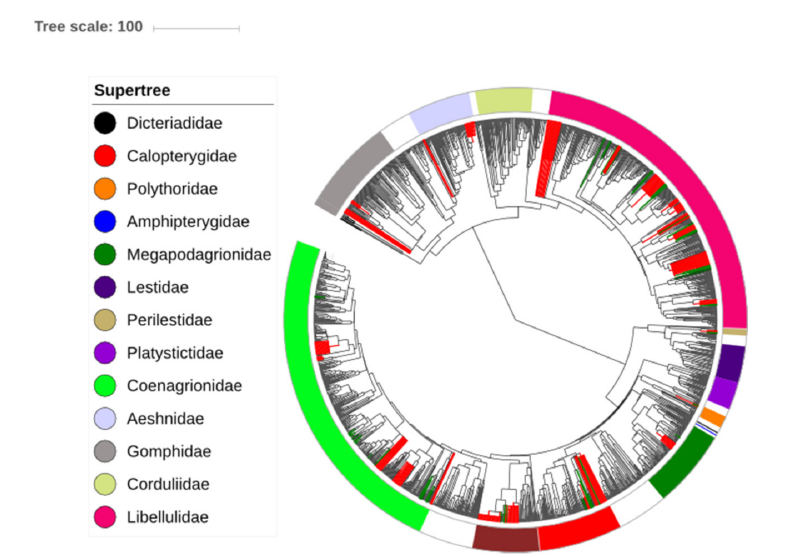
Figure 2. Phylogenetic tree of the Odonata (modified from Waller and Svensson [56]). The branches indicate the evolutionary relationships between taxa worldwide, while green branches are Amazonian taxa and red branches are Amazonian species without molecular data inserted at the root of their respective genera (which were never included before). Families listed in the legend occur in the Brazilian Amazon and are highlighted in the phylogenetic tree according to the respective